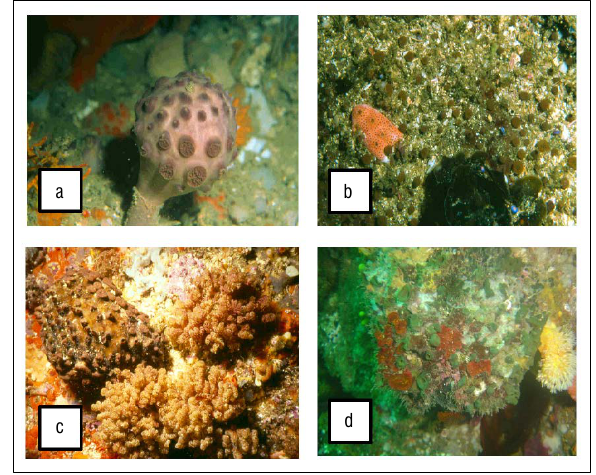
Figure 5: Underwater photographs of (a) Tsitsikamma pedunculata , (b) Cyclacanthia bellae , (c) Strongylodesma algoaensis and (d) S. aliwaliensis (photos: P. Colin and T. Samaai).